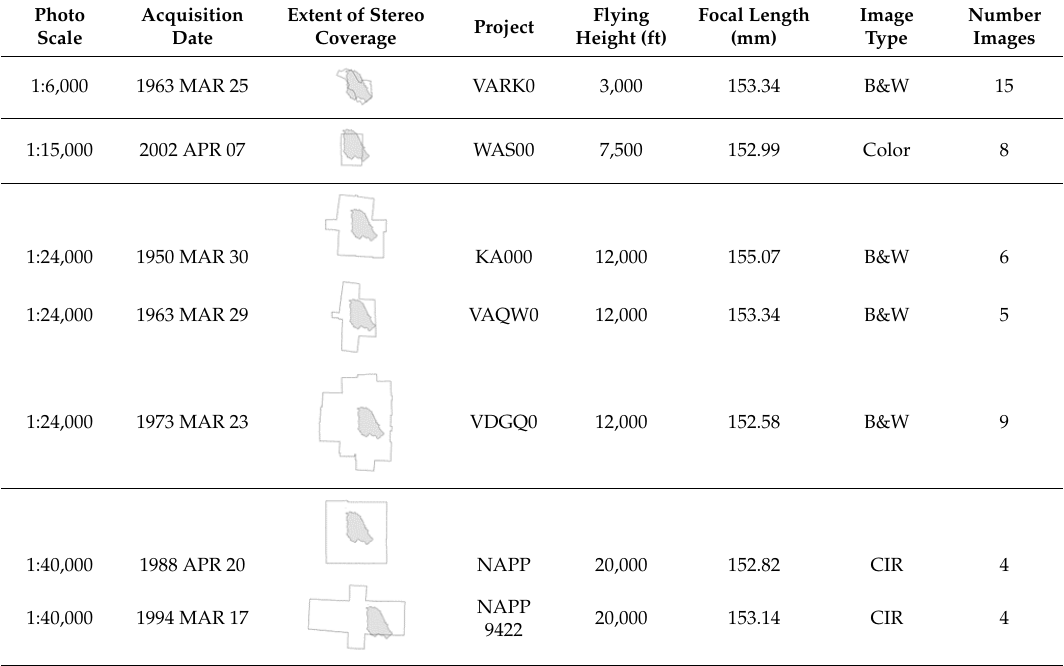
Table 3. Stereo aerial imagery sets used in the study.